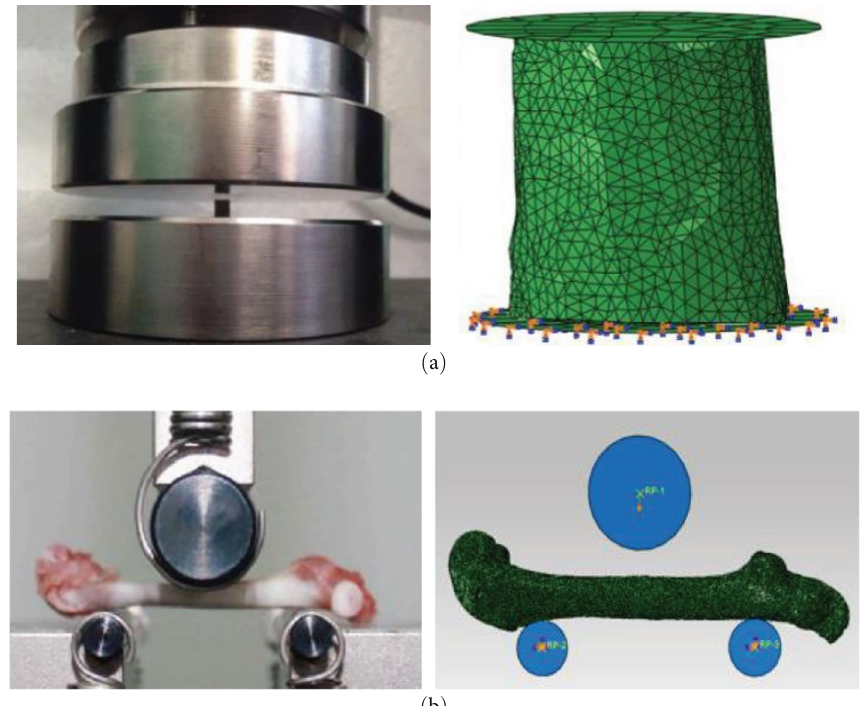
F IGURE 1: Schematic diagrams of the experiments and simulations on the rat femurs: (a) compression experiment and simulation; (b) three-point bending experiment and